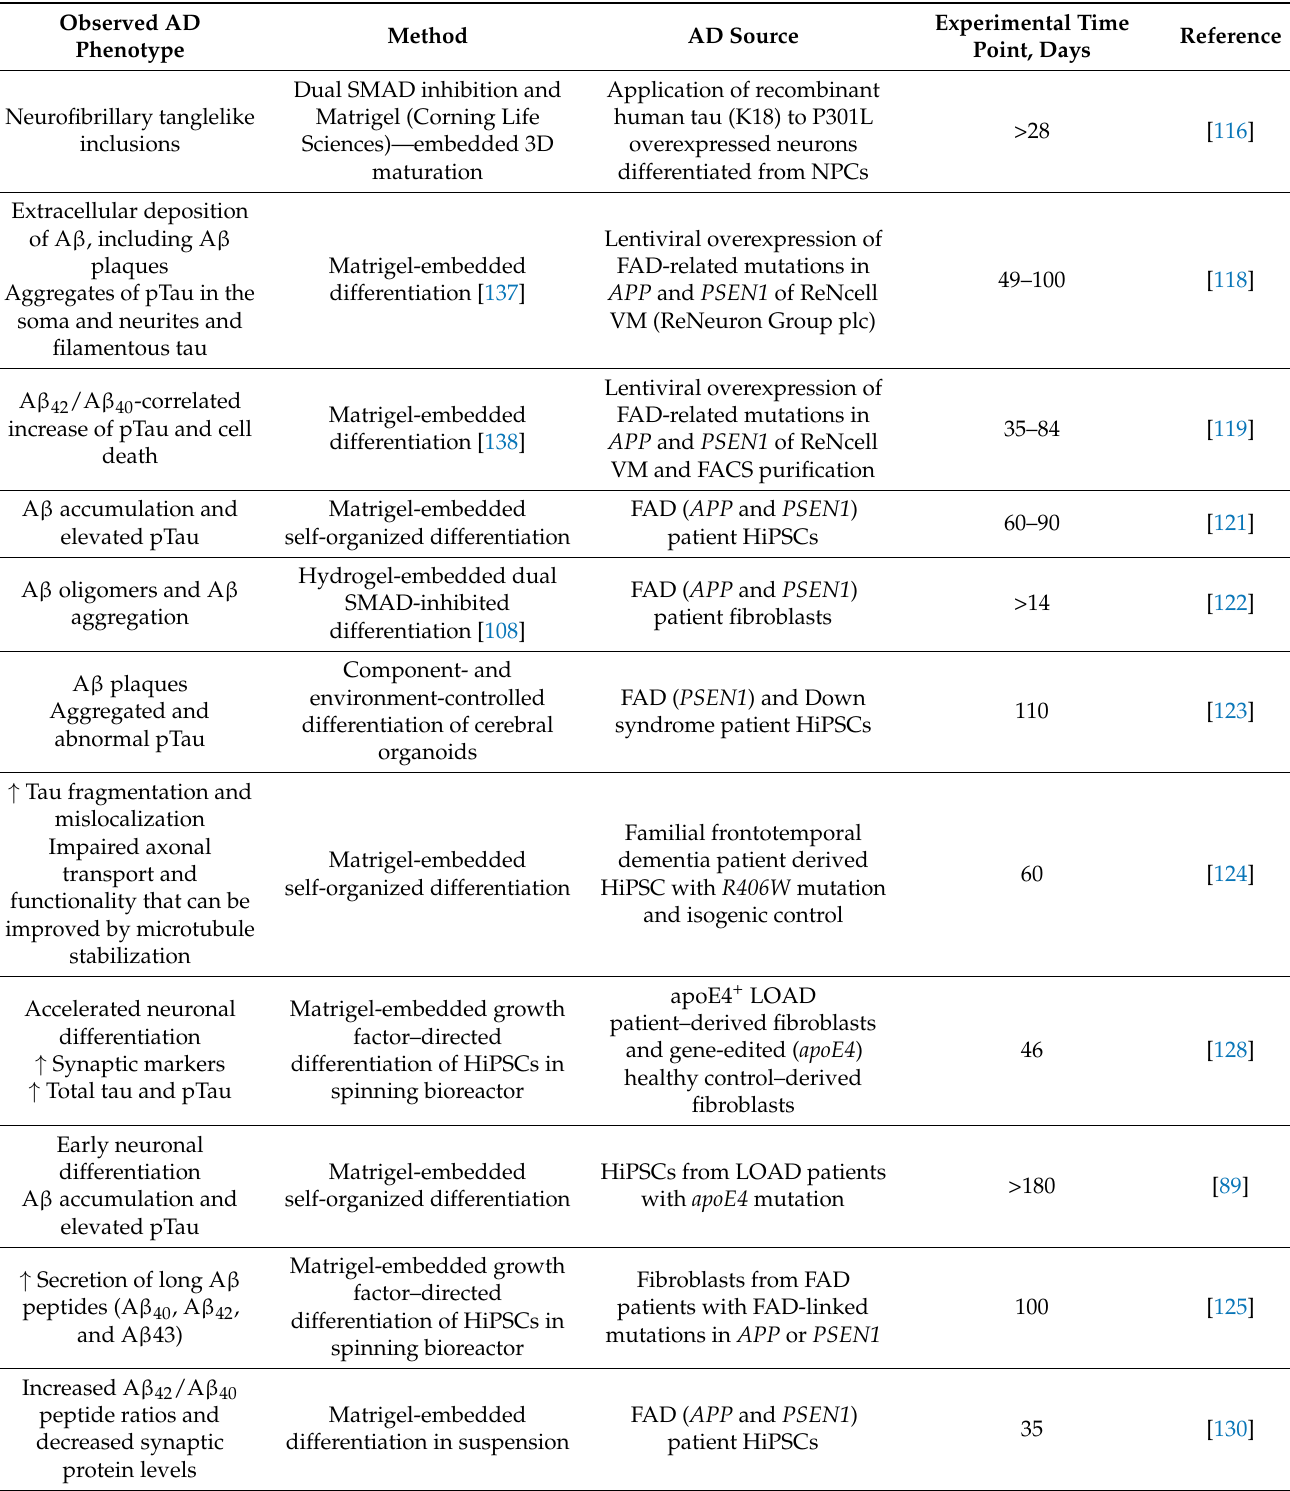
Table 2. Spheroid and organoid models of